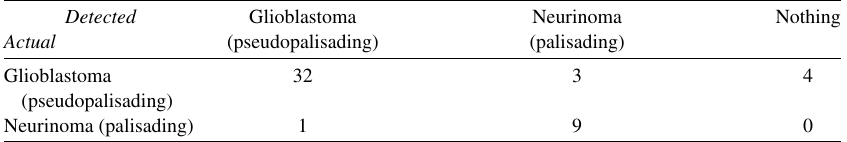
Results of testing the correctness of the proposed method